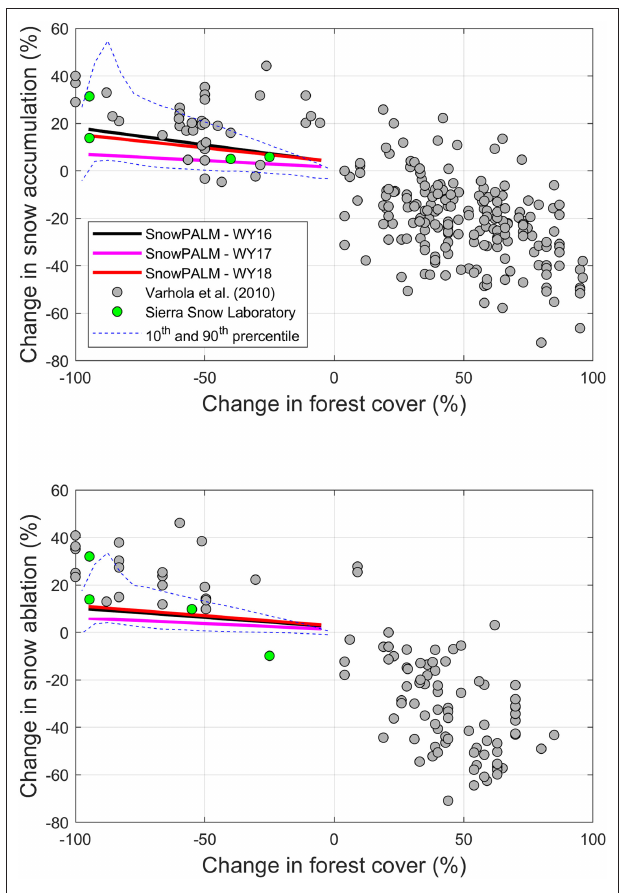
FIGURE 14 | Changes in peak snow accumulation (upper) and snow ablation (melt + snowpack sublimation) (lower) against changes in forest cover comparing the data from Varhola et al. (2010, Figure 8) meta-analysis and linear regressions for the three water years and both thinning scenarios simulated by SnowPALM at a 30-m forest stand scale. Dashed lines show the 10th and 90th percentile of all the 30-m forest stands used in the regression lines. Green dots highlight those points from Varhola et al. (2010) that are the closest to our study